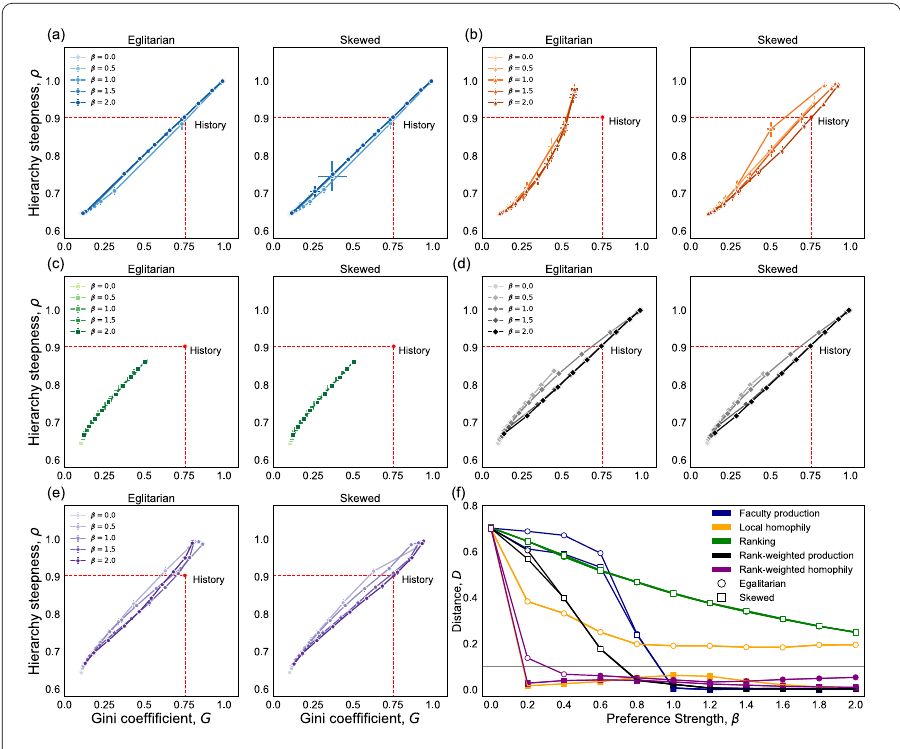
Figure S3 Best-fit values of the random hiring parameter p for the History faculty hiring network. ( a )–( e ) Steady-state values of Gini coefficient G and hierarchy steepness ρ , for the five hiring models and two initial conditions for different choices of β (for simplicity, we only show β ∈ { 0.0,0.5,1.0,1.5,2.0 } ). Each line is a parametric plot in which we vary the randomness parameter over 0 ≤ p ≤ 1, and hence all models and choices of β converge to the same point in inequality-space as p → 1. Red dashed lines show the empirical values of G and ρ for the History faculty hiring network. Results are averaged over 50 simulations, and error bars indicate standard deviations. ( f ) Euclidean distance between an averaged structural inequality ( G , ρ ) obtained from simulation and their pair of empirical values for the History hiring network. Filled markers represent β values that can reproduce G and ρ with distance D ≤ 0.1; open markers indicate D > 0.1 or a model is not able to reproduce the empirical